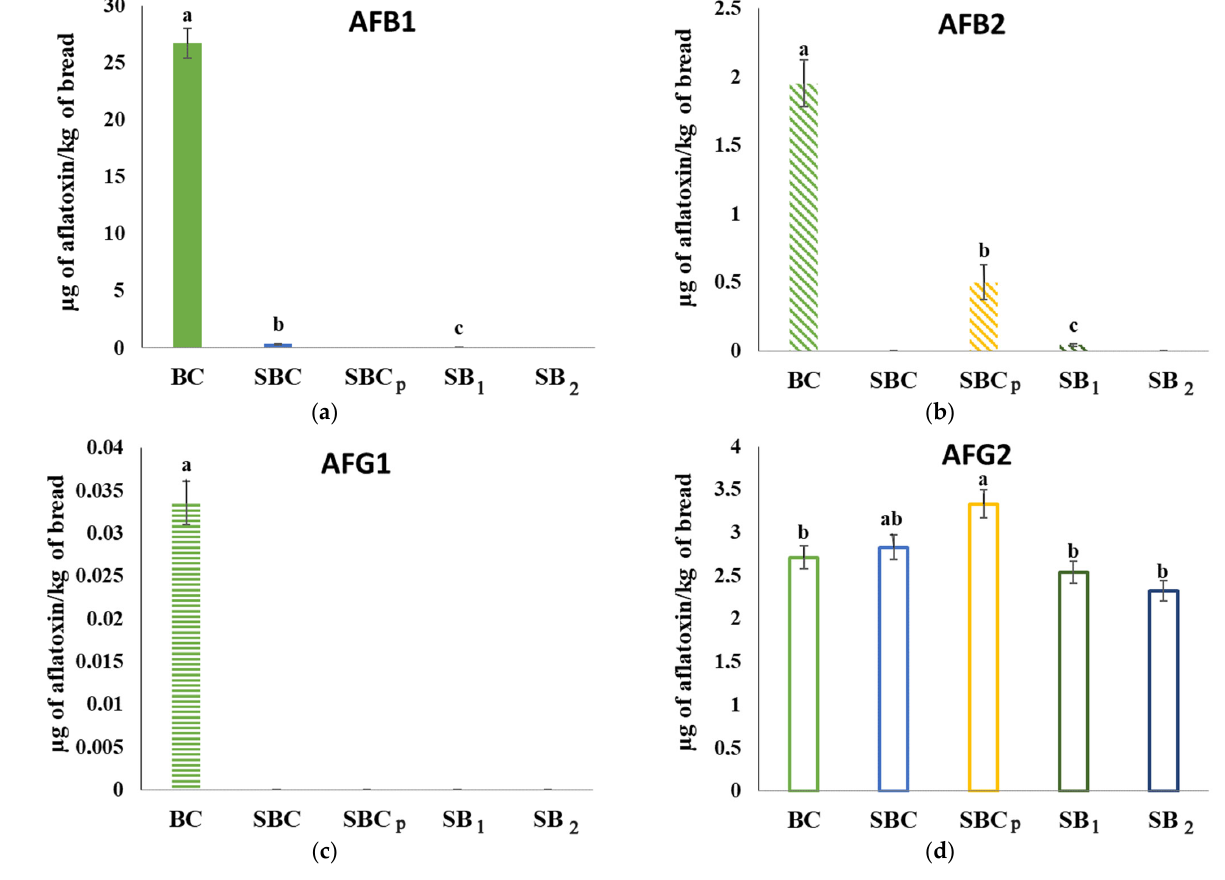
Figure 6. Production of aflatoxins in breads inoculated with A. flavus . ( a ): AFB1; ( b ): AFB2; ( c ): AFG1; ( d ): AFG2. The samples received the following treatments: BC: bread control; SBC: sourdough bread control; SBC p : sourdough bread control with propionate; SB 1 : sourdough bread with L. plantarum 5L1 inoculum (0.5%); SB 2 : sourdough bread with L. plantarum 5L1 inoculum (5%); AFB1: Aflatoxin B1; AFB2: Aflatoxin B2; AFG1: Aflatoxin G1; AFG2: Aflatoxin G2. Different lower ‐ case letters indi ‐